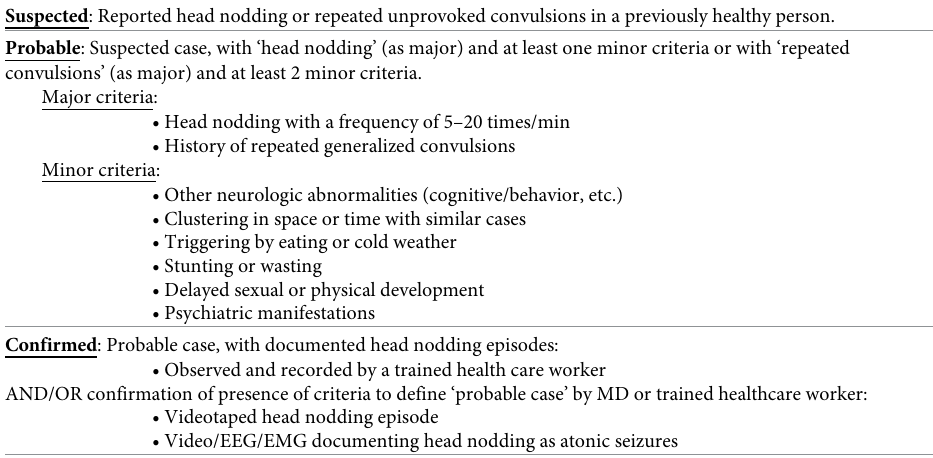
Table 1. Nodding syndrome case definition. Suspected : Reported head nodding or repeated unprovoked convulsions in a previously healthy person. Probable : Suspected case, with ‘head nodding’ (as major) and at least one minor criteria or with ‘repeated convulsions’ (as major) and at least 2 minor criteria. Major